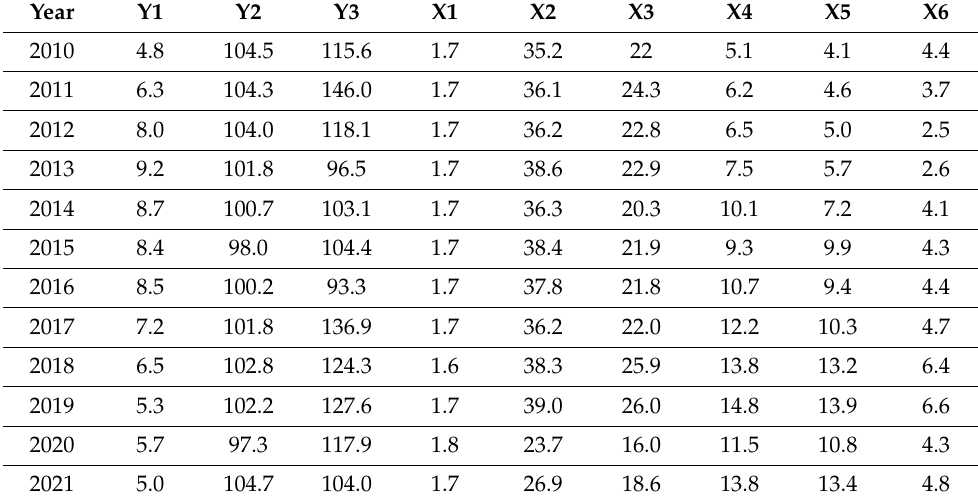
Table 1. Indicators of the development of the financial sector ecosystem in the context of the digital economy (data are presented for the Russian Federation in percentages).